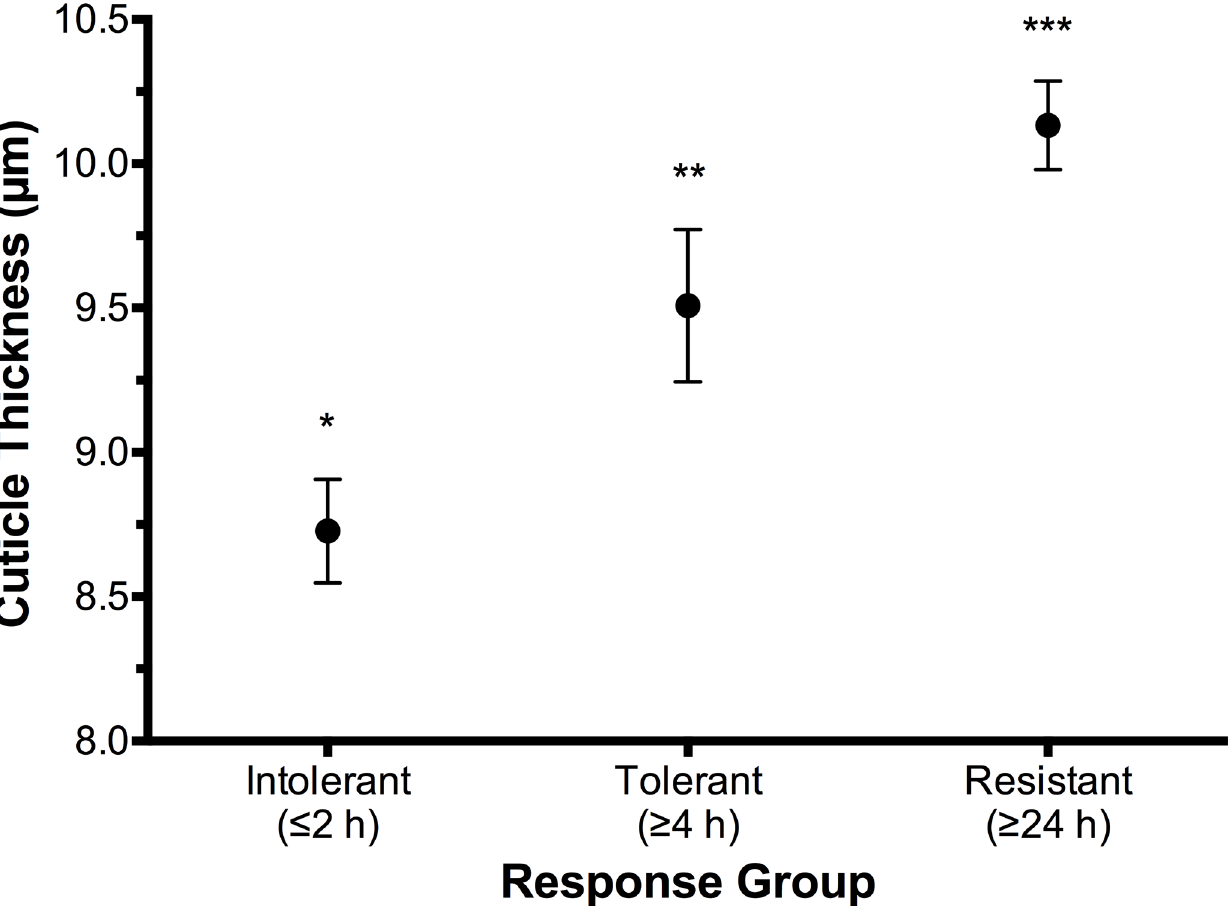
Fig 3. Mean cuticle thickness ( μ m ± S.E) of intolerant (n = 10), tolerant (n = 10) and resistant (n = 10) response group Parramatta strain Cimex lectularius . Asterisks ( * ) indicate statistical significance (p < 0.05).